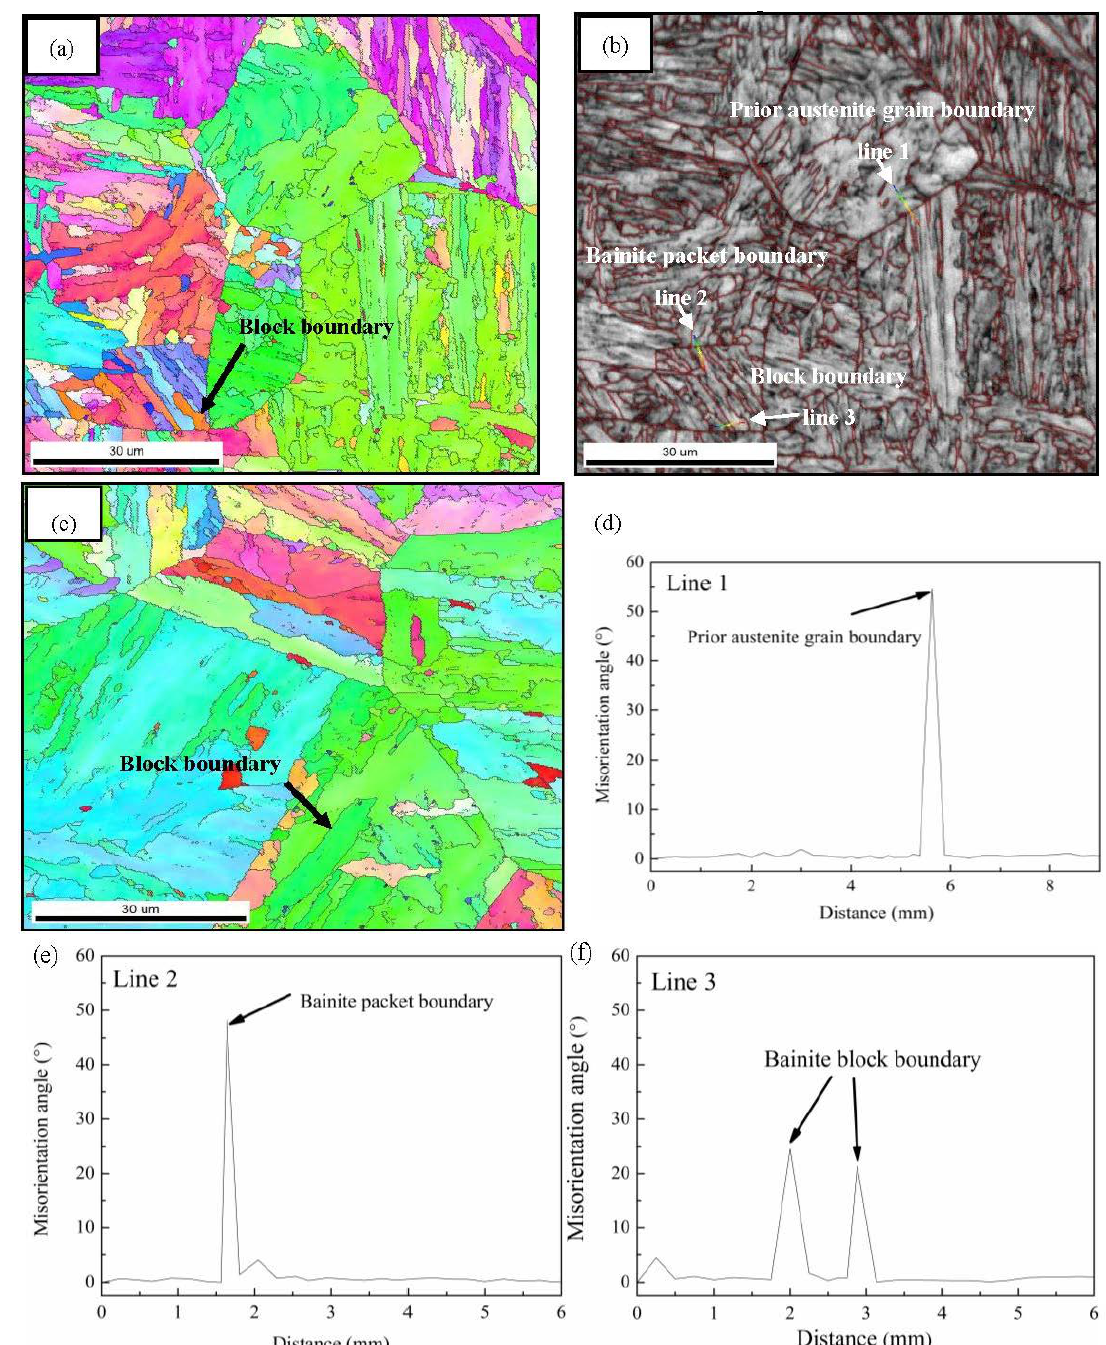
Figure 5. EBSD (electron backscattering diffraction) misorientation maps of X90 pipeline steel processed with different heat inputs: ( a , b ) 30 kJ/cm; ( c ) 60 kJ/cm. The black ( a , c ) and the red ( b ) grain boundary all represent high angle boundary with misorientation angles greater than 15°. Line 1 ( d ), line 2 ( e ), and line 3 ( f ) reveal the misorientation distributions between the neighboring prior austenite grain boundary, the bainite packet boundary, and the block boundary, respectively.